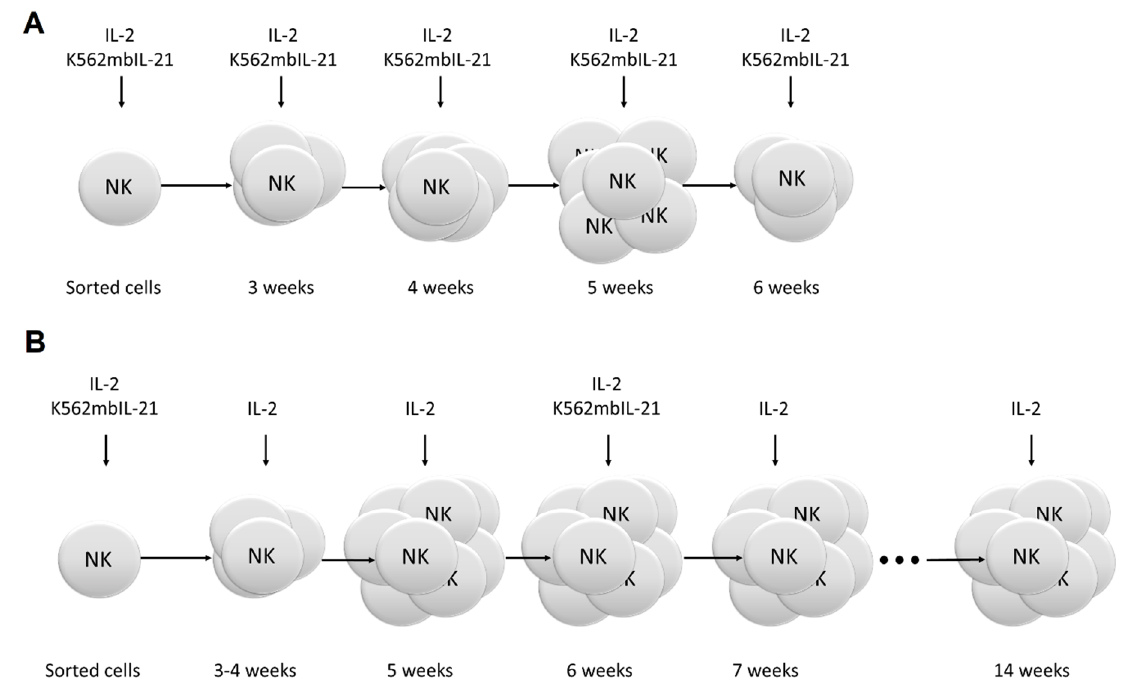
Figure 2. Schemes of NK cell clone cultivation procedures. ( A ) Model 1—weekly addition of feeder cells, starting from the third week. ( B ) Model 2—single addition of feeder cells at week six.